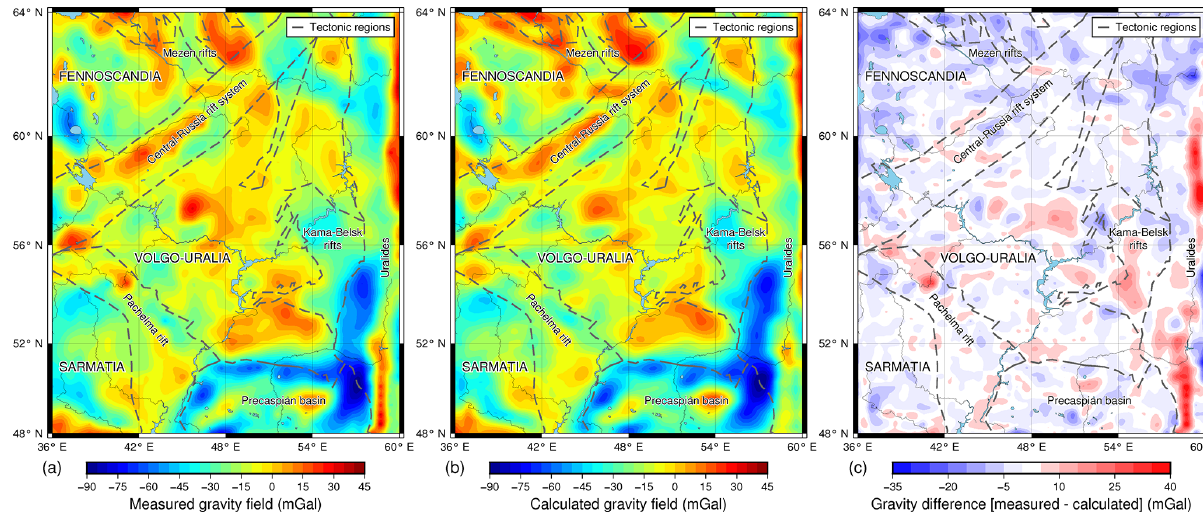
Figure 6. Comparison between measured and calculated gravity fields. (a) XGM2019e Bouguer gravity anomaly (Zingerle et al., 2019). (b) Calculated Bouguer gravity anomaly from IGMAS + 3D model. (c) The difference between measured and calculated gravity